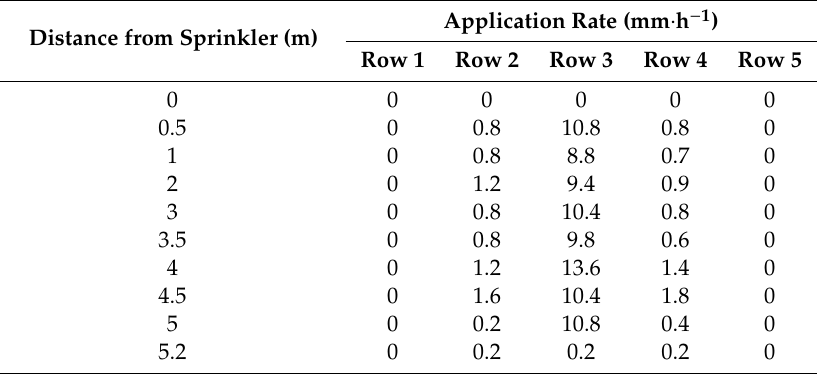
Table 2. Measured water distribution pattern from a single groove with 1 m mounting height.